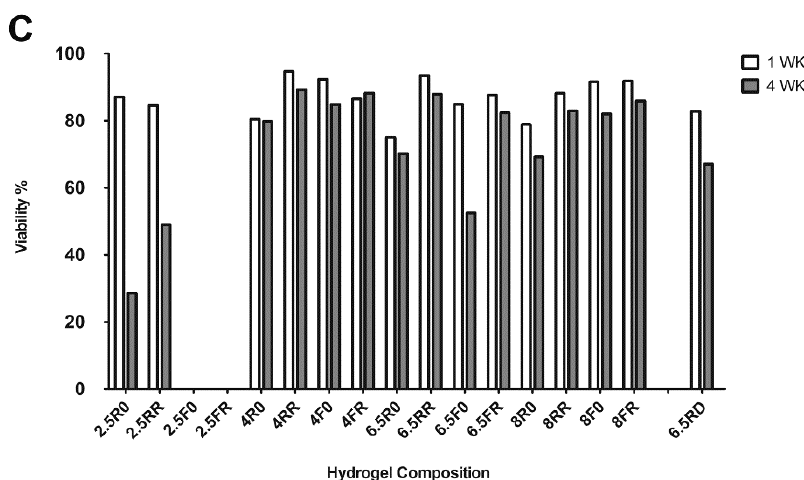
Figure 1. Human periosteum-derived cell (hPDC) viability within PEG-VS hydrogels made with different concentrations of macromer, different protease sensitive cross-linkers (R or F), and with or without the cell binding motif RGD or scrambled RDG after 1 week ( A ) and 4 weeks ( B ) of in vitro culture in GM. Representative images of Live/Dead staining with calcein AM (green, live cells) and ethidium homodimer-1 (red, dead cells). Confocal images are depicted as the maximum intensity of a 500 µ m z-stack that was acquired using a 10 × objective (scale bars = 200 µ m). ( C ) IMARIS software based quantification of viability percentages of cells encapsulated in polyethylene glycol (PEG) hydrogels ( n = 1 independent sample; values depicted are the averages of two different measured areas within one sample).